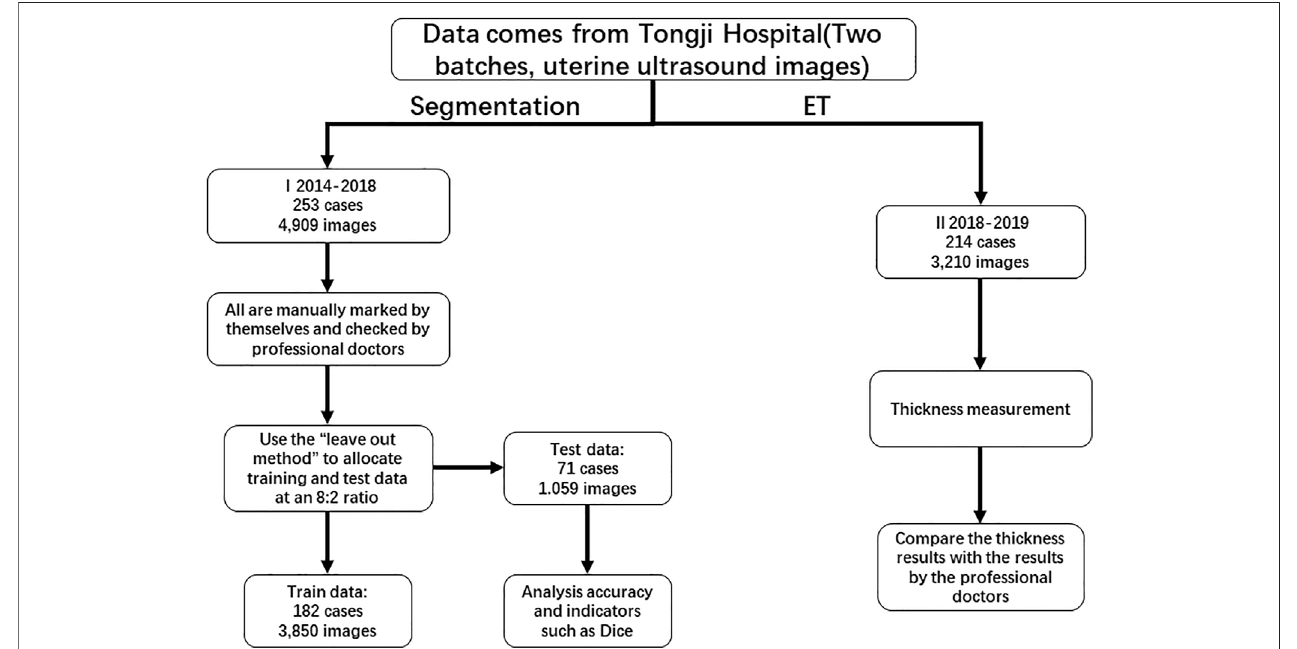
FIGURE 1 | Study overview.